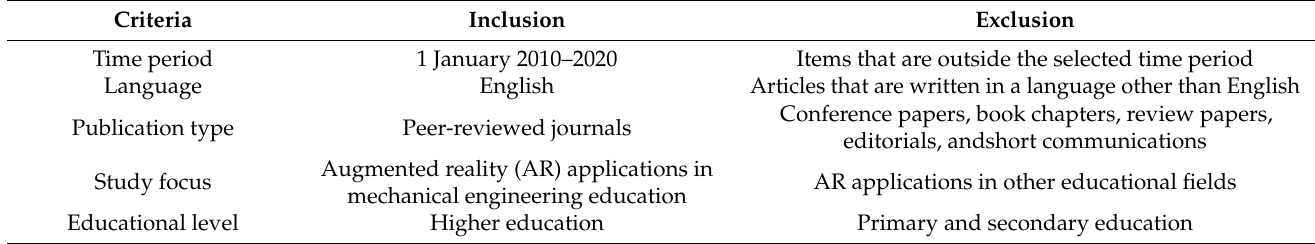
Table 1. Inclusion and exclusion